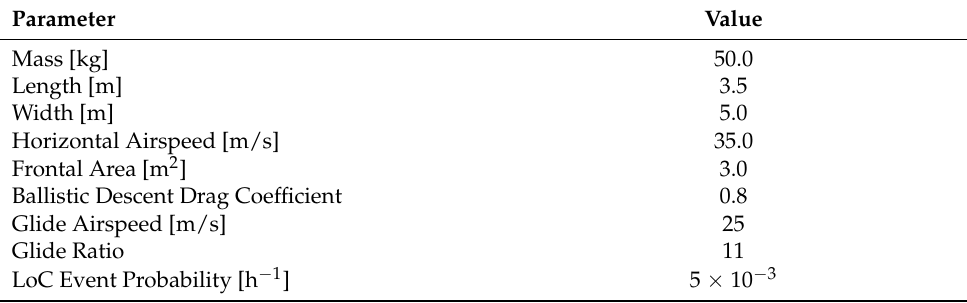
Table 1. Parameters of the Mugin 5 Pro aircraft used as an